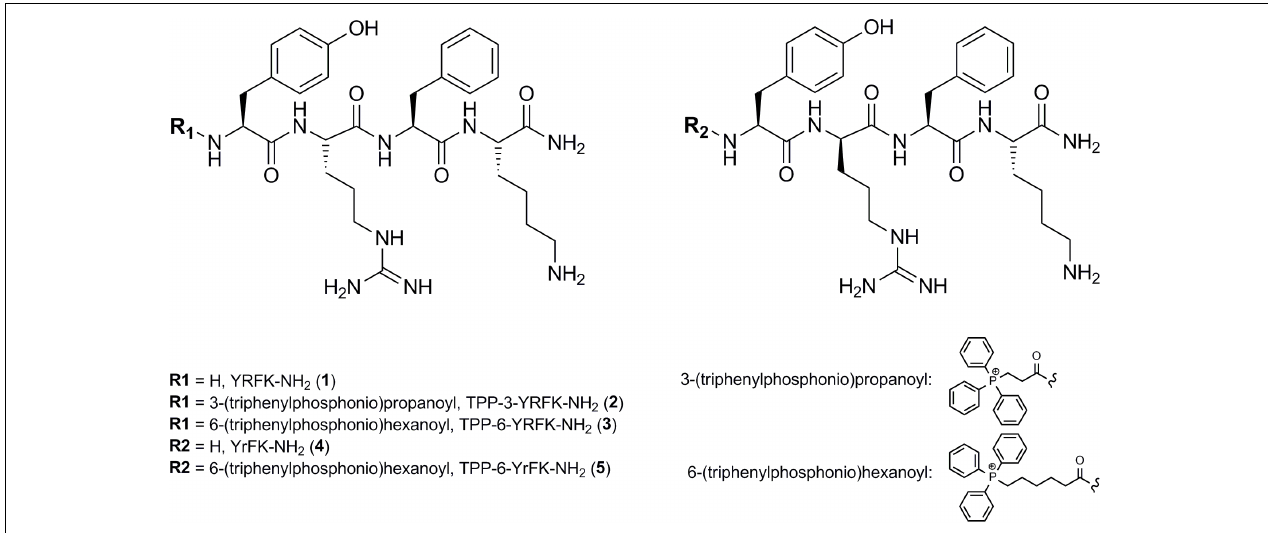
FIGURE 1 | Structure of synthesized YRFK tetrapeptides and their triphenylphosphonium derivatives.